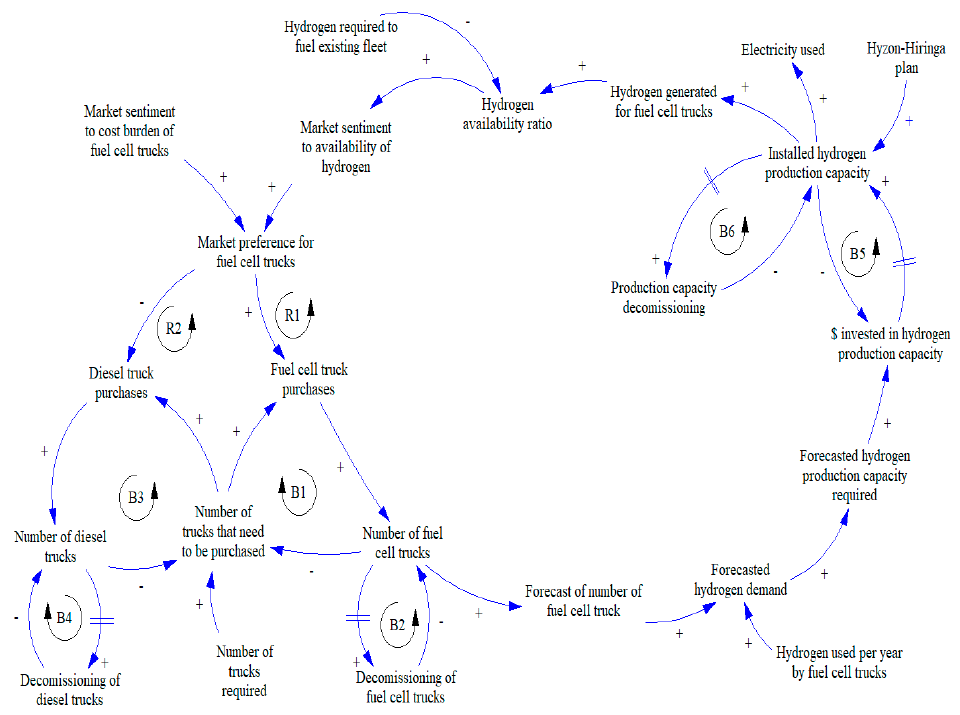
Figure 2. Dynamic hypothesis for investigating a transition from diesel to fuel cell trucks.